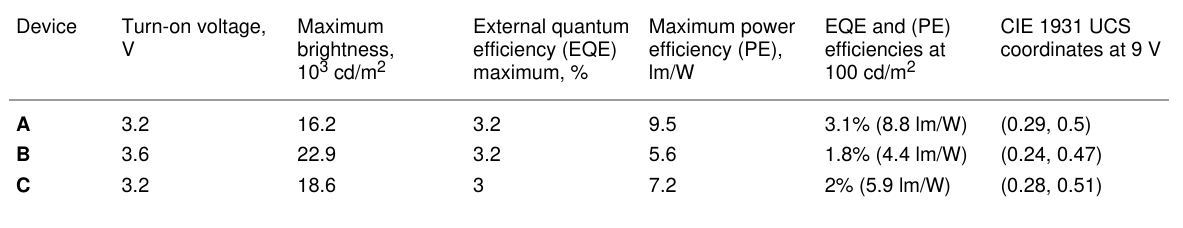
Table 3: Electroluminescence characteristics of